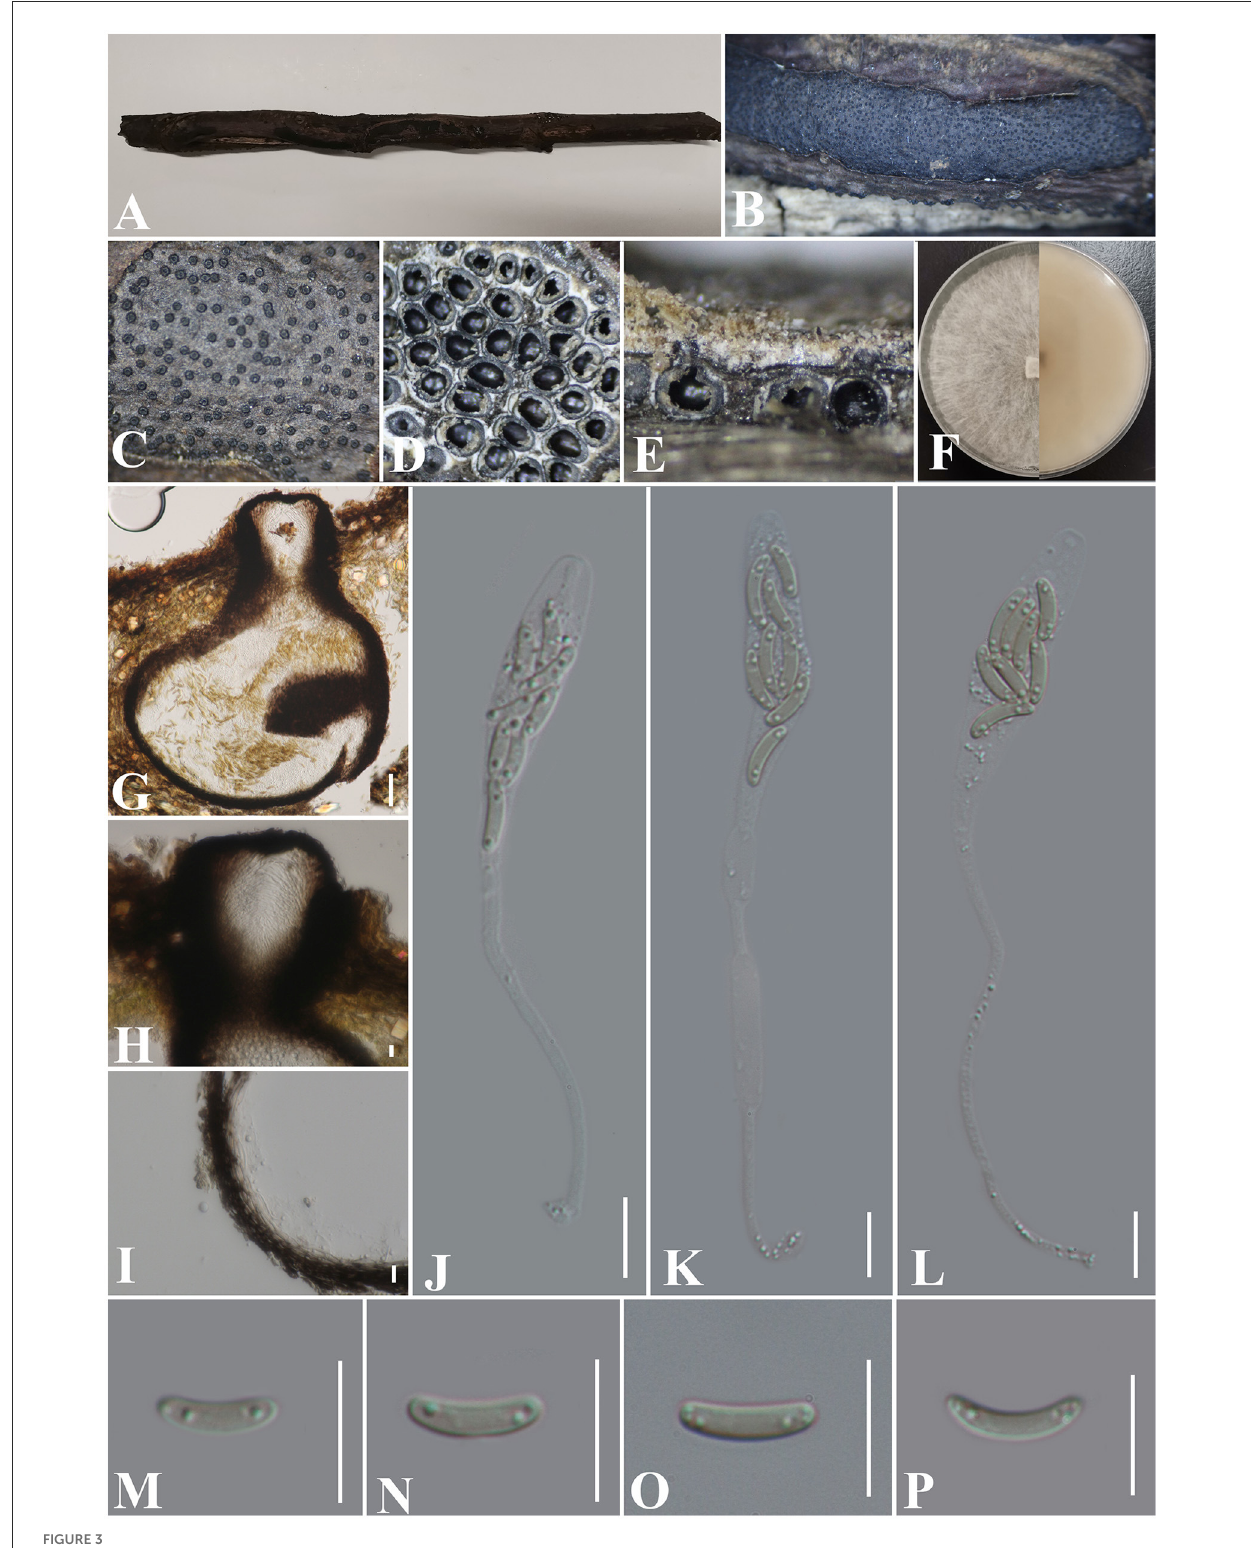
FIGURE3 Allocryptovalsa xishuangbanica (GMB0417). (A) Material. (B, C) Close-up of stromata. (D) Transverse section through stromata. (E) Vertical section through stromata. (F) Cultures on PDA. (G) Section through the ascostroma. (H) Ostiolar canal. (I) Peridium. (J–L) Asci. (M–P) Ascospores. Scale bars: (G) = 50 µ m; (H–P) = 10 µ